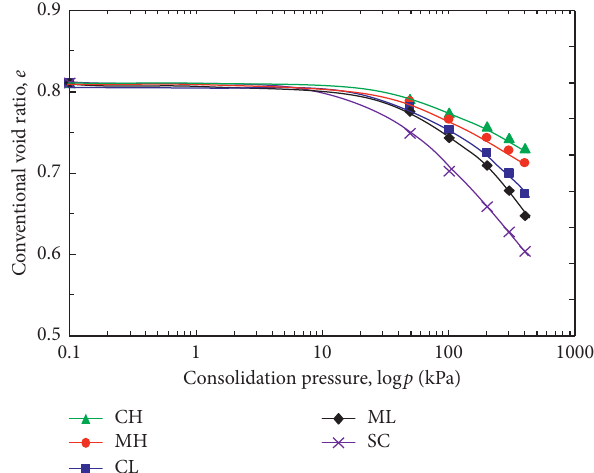
Figure 7: Compressive behavior of saturated soils with the same initial conventional void ratio.